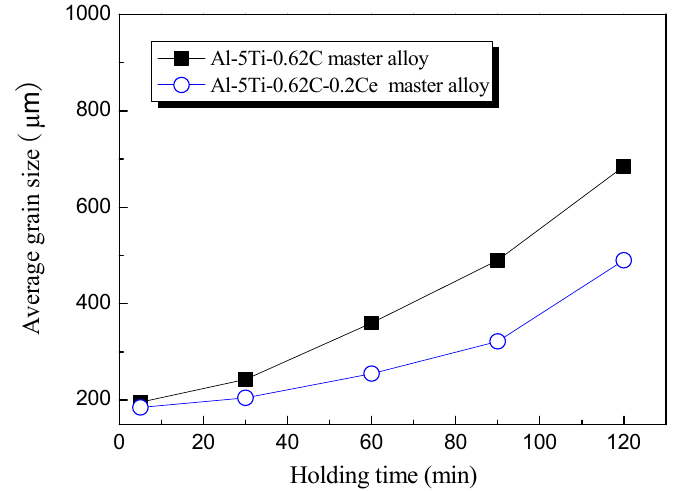
Figure 7. The relation curve between holding time and the average size of solidified commercial pure aluminum samples refined with 0.3% Al-5Ti-0.62C and Al-5Ti-0.62C-0.2Ce master alloy.